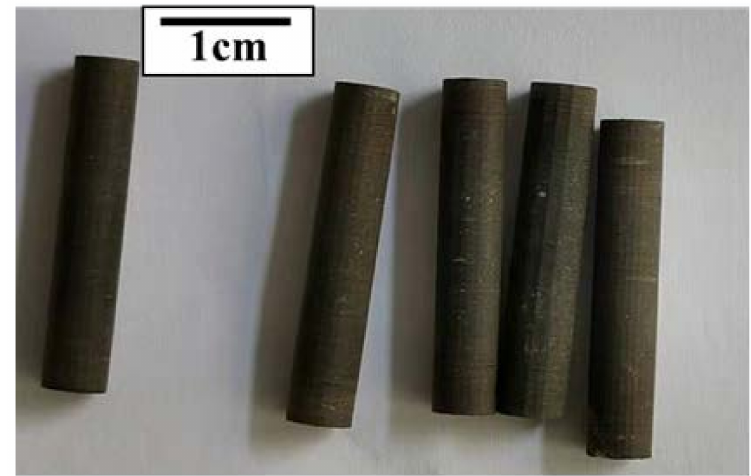
Figure 1. Examples of core plugs drilled from bulk Maoming oil shale.